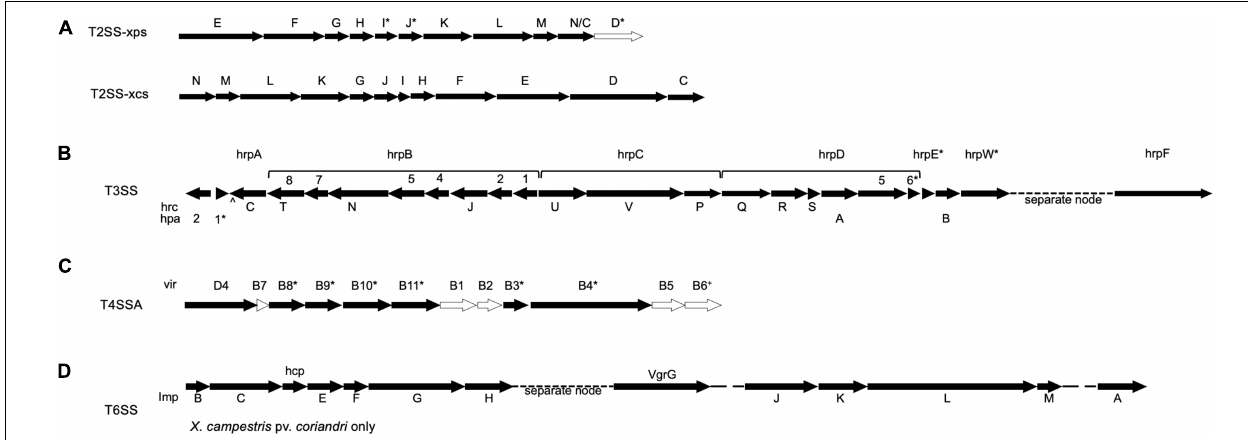
FIGURE 5 | Predicted Secretion system gene clusters for Xhv and related Xanthomonas strains. Presence of each labeled gene in the majority of Xhv and related strains is indicated by a black arrow, and absence from all strains is indicated by a white arrow. Asterisks, carets, and crosses indicate exceptions listed here. (A) T2SSs xps and xcs—exceptions include X. hortorum pv. taraxaci and X. hortorum pv. gardneri , for which the entire xps gene cluster is predicted, and Xhv race 1 strain BP5179, for which the genes xpsI , xpsJ , and xpsD were truncated; (B) T3SS—exceptions include X. hortorum pv. hederae , which had a large insertion between hpa1 and hrcC and lacked hrpE , X. campestris pv. coriandri , which lacked hpa1 and hrpW , and X. hortorum pv. pelargonii , which lacked hrpE and hrpD6 ; (C) T4SSA—exceptions include Xhv race 1 strains BS0541 and BS3044, which encoded the additional gene virB6 , X. hortorum pv. gardneri , which encoded the additional virB6 gene and lacked virB11 , X. hortorum from radicchio, which only encoded for virD4 , and X. campestris pv. coriandri , which only encoded for virB4 , virB8 , virB9 , and virD4 ; and (D) T6SS—which was only predicted for the X. campestris pv. coriandri strain and not found in any other strain